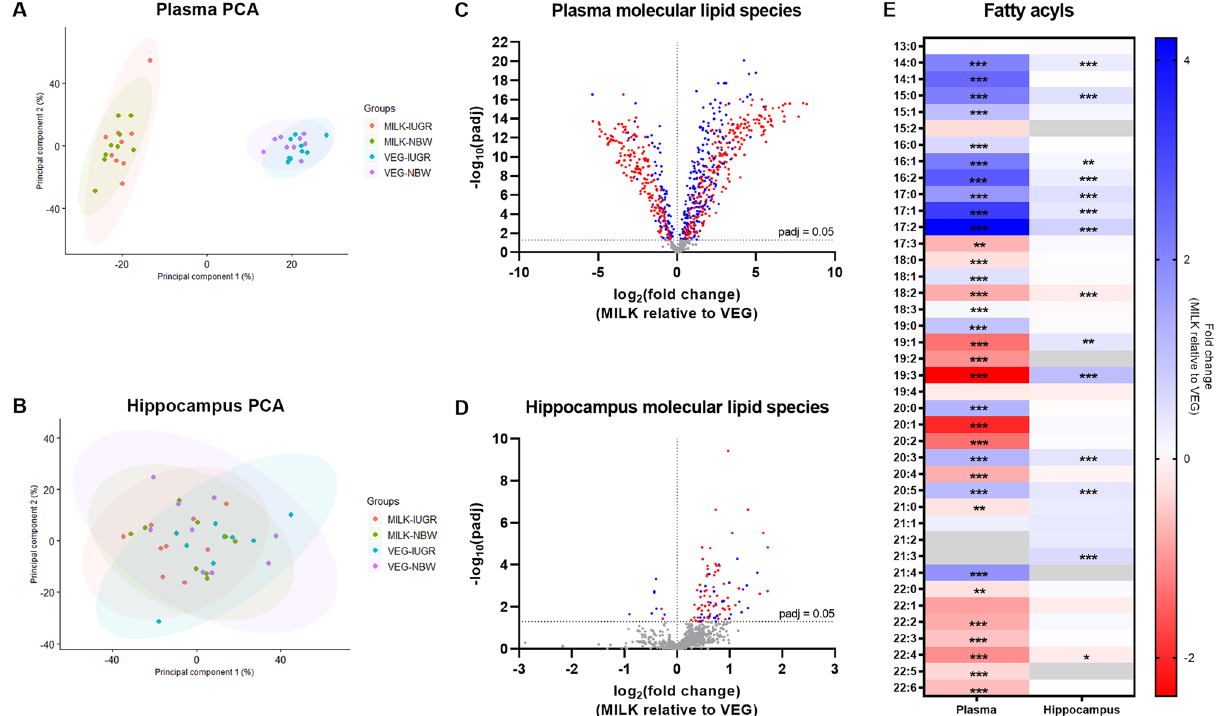
Figure 3 . Plasma and hippocampal lipidomics on day 21–22. ( A , B ) Principal component analysis plots of absolute molecular lipid species data, ( C , D ) volcano plots of molecular lipid species in plasma and hippocampal tissue, ( E ) total fatty acyl analysis. In ( C ), red dots indicate triacylglycerol species. In ( D ), red dots indicate glycerophospholipid species. Grey cells in ( E ) indicate that the fatty acyl chain was b elow the lower limit of detection. In ( A ) and ( B ), n = 9. In ( C , D ) and ( E ), data are pooled and presented as main effects of diet (n = 12–18). Data are shown as fold-change of the MILK relative to VEG group ( C , D , E ). Data were analysed using a principal component analysis ( A , B ) or linear mixed model ( C , D , E ). A Benjamini–Hochberg correction was applied in ( C ), ( D ) and ( E ). Statistically significant differences between groups are shown as *p < 0.05, **p < 0.01, ***p < 0.001 or as values above the horizontal dotted line (padj < 0.05). Figures were created with R (version 4.0.3, R Foundation for Statistical Computing, Vienna, Austria) ( A , B ) and GraphPad Prism